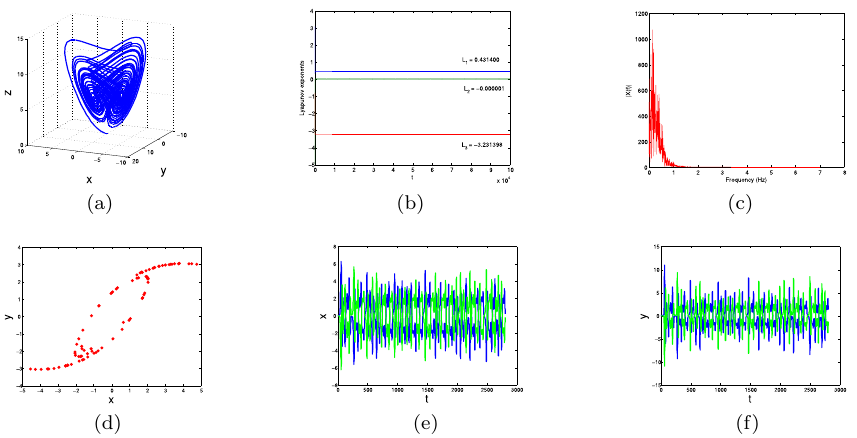
Figure 1. (a) Chaotic attractor of system (1.3), (b) its Lyapunov exponents L 1 = 0 . 4314, L 2 = − 0 . 000001 and L 3 = − 3 . 231398, (c) single-sided amplitude spectrum of | x ( t ) | , (d) the Poincar´e map of x – y plane for z = 6, (e) time series of x ( t ) for ( x 0 ,y 0 ,z 0 ) = ( ± 3 . 82 e − 5 , ± 6 . 18 e − 5 , 0), (f) time series of y ( t ) for ( x 0 ,y 0 ,z 0 ) = ( ± 3 . 82 e − 5 , ± 6 . 18 e − 5 , 0) of system (1.3) for the parameters ( a,b,c ) = (3 , 5 , 0 . 8). These figures display that system (1.3) is a chaotic